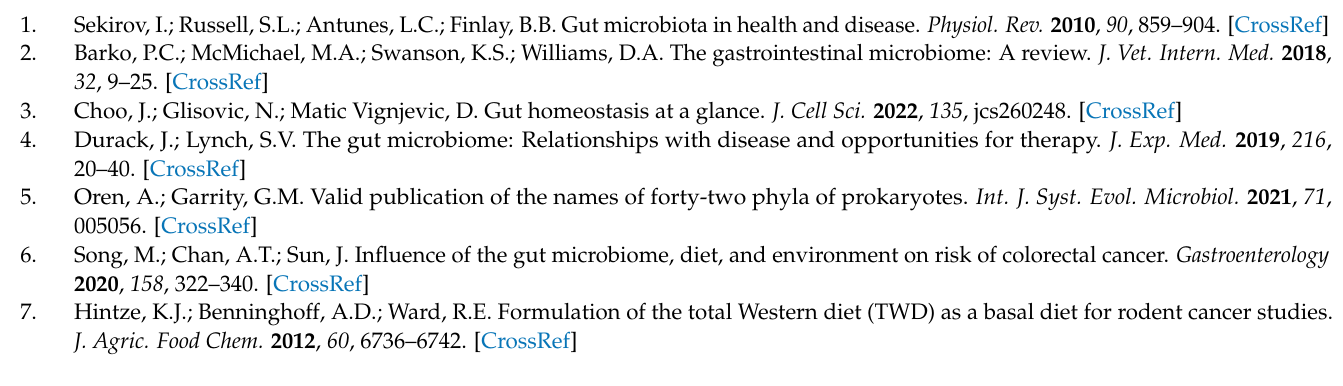
points; Table S1: Experimental diet formulations; Table S2: Alpha diversity pairwise comparisons for the effects of time point only, irrespective of basal diet or FMT source; Table S3: Alpha diversity pairwise comparisons by experimental group within time points; Table S4: Alpha diversity pairwise comparisons by time point within experimental group; File S1. Microbiome count data.xlsx; File